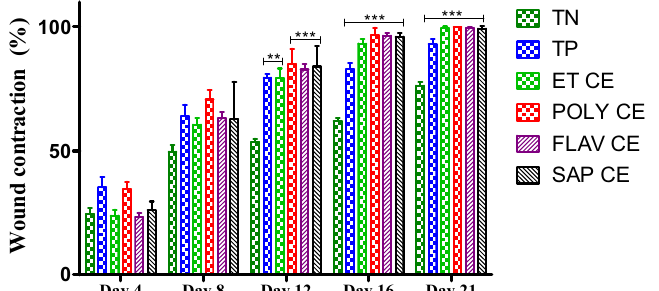
Figure 3. Wound contraction rate (%) on the 21 days of animal experiment. TP, Positive control; TN, Negative control ET, Total extract; POLY, Polyphenols; FLAV, Flavonoids; SAP, Saponins. Value significantly different compared to negative control: **: p < 0.01, ***: p < 0.001.